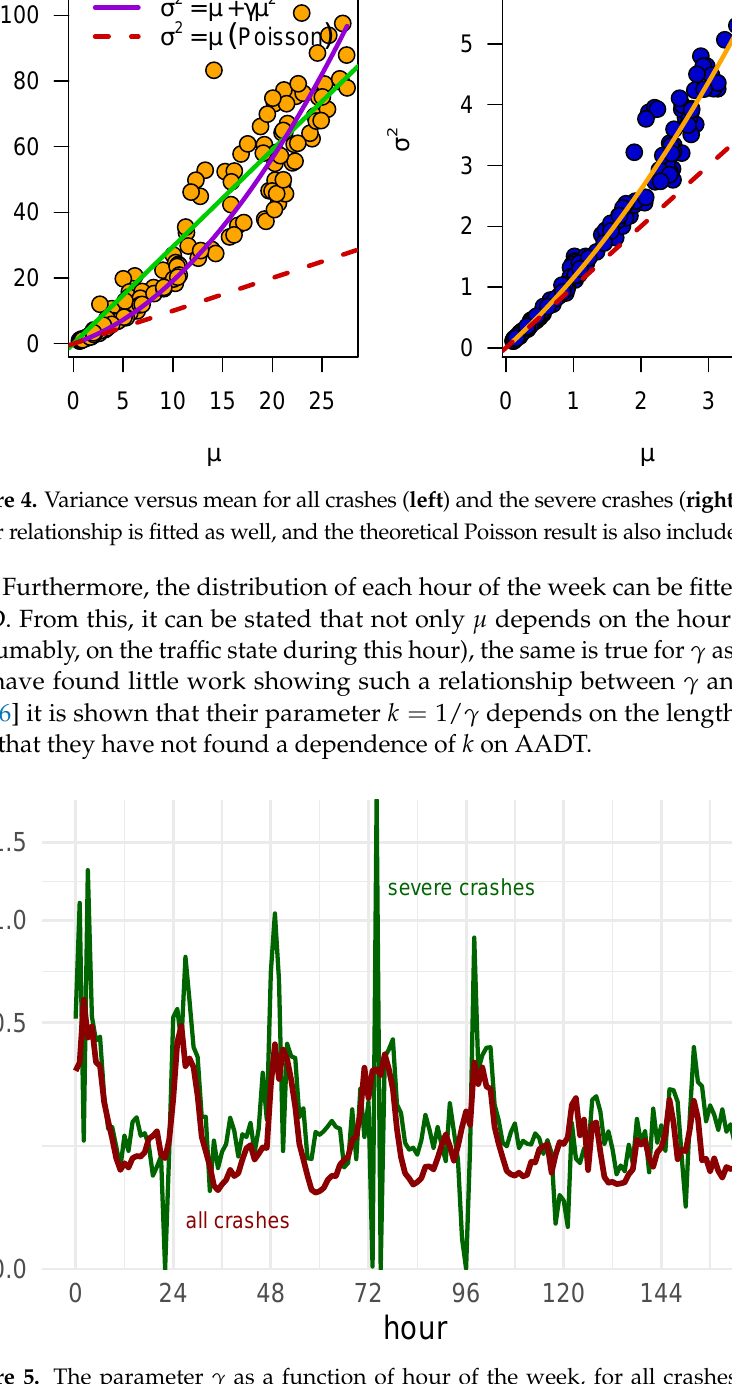
Figure 5. The parameter γ as a function of hour of the week, for all crashes (dark-red) as well as for the severe crashes (dark-green). Whenever the fit has failed, γ has been computed from γ = ( σ 2 − µ ) / µ 2 . These curves are not